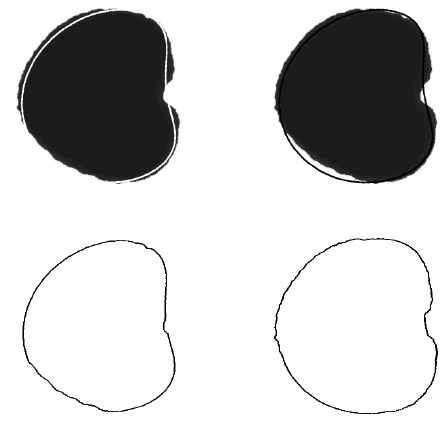
Figure 1. Representation of the method used to calculate J index. Top: Seed images with the model superimposed. Left: The model is in white to obtain the shared area ( S ). Right: The model is in black to obtain the total area ( T ). Below: Interpretation of the images by ImageJ. The estimated areas, shared ( S ) and total ( T ), are of 159479 and 177362 pixel, respectively. The J index of this example equals to 89.9.